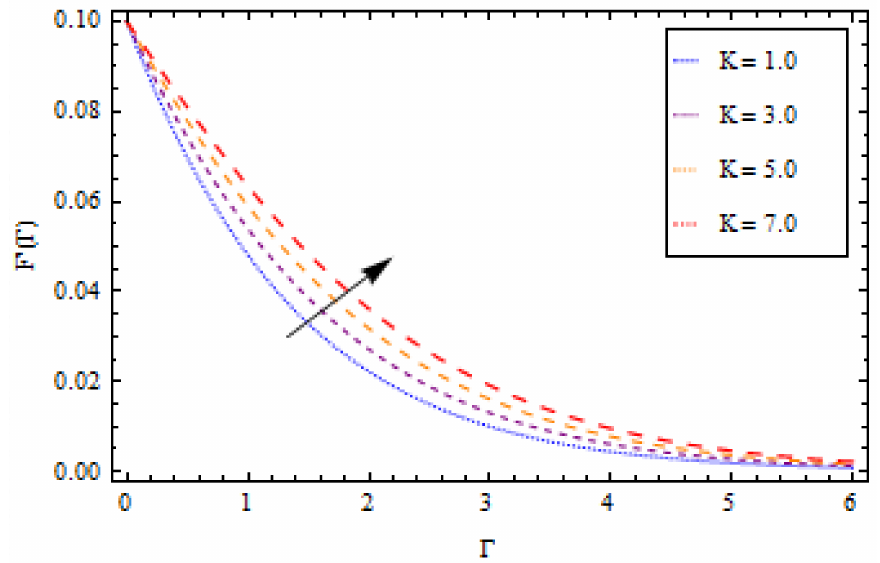
Figure 8. Impact of K on velocity profile F (cid:48) ( Γ ) , when Pr = 0.5, Rd = 0.5, λ = 0.5, κ = 0.5, γ = 0.5, Sin τ = 1.0, A =